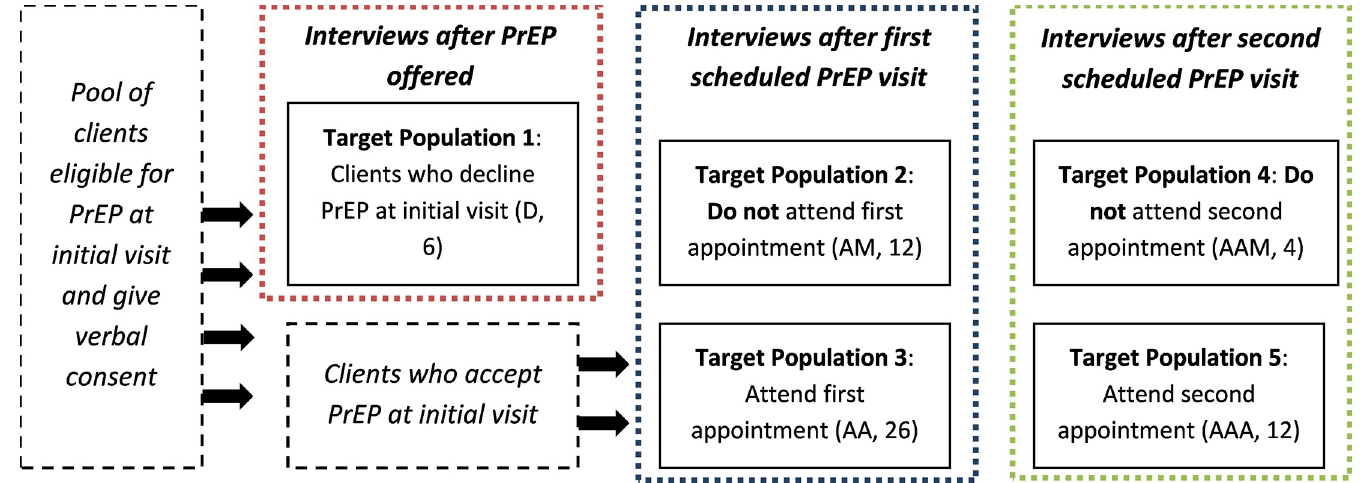
Fig 1. Client interview flow and number of interviews